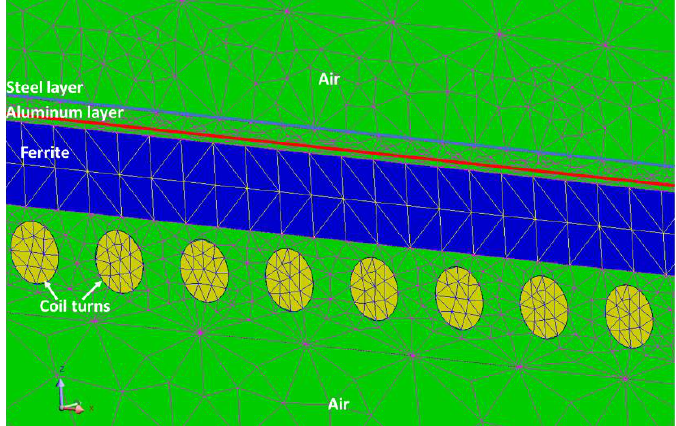
Figure 2. mesh particular of a cross-section in the vertical plane. Figure 2. Mesh particular of a cross-section in the vertical